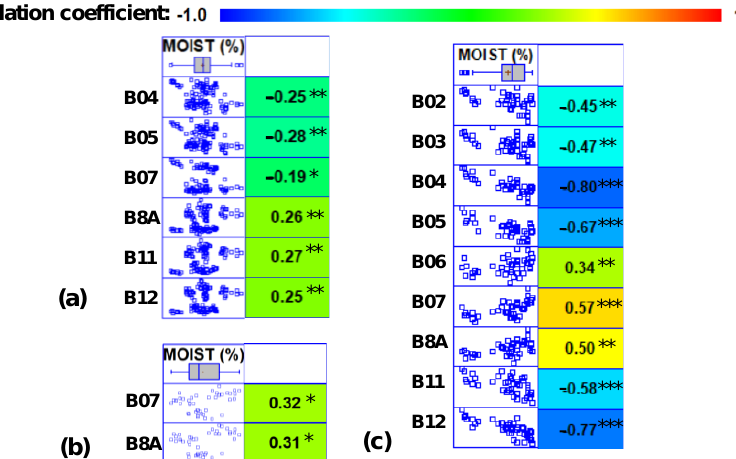
Figure 6. Summary of multivariate analyses. ( a ) all soil types, ( b ) sandy soil, and ( c ) clay soil. Significance levels (Sig): *** p < 0.001; ** p < 0.010; * p < 0.05.